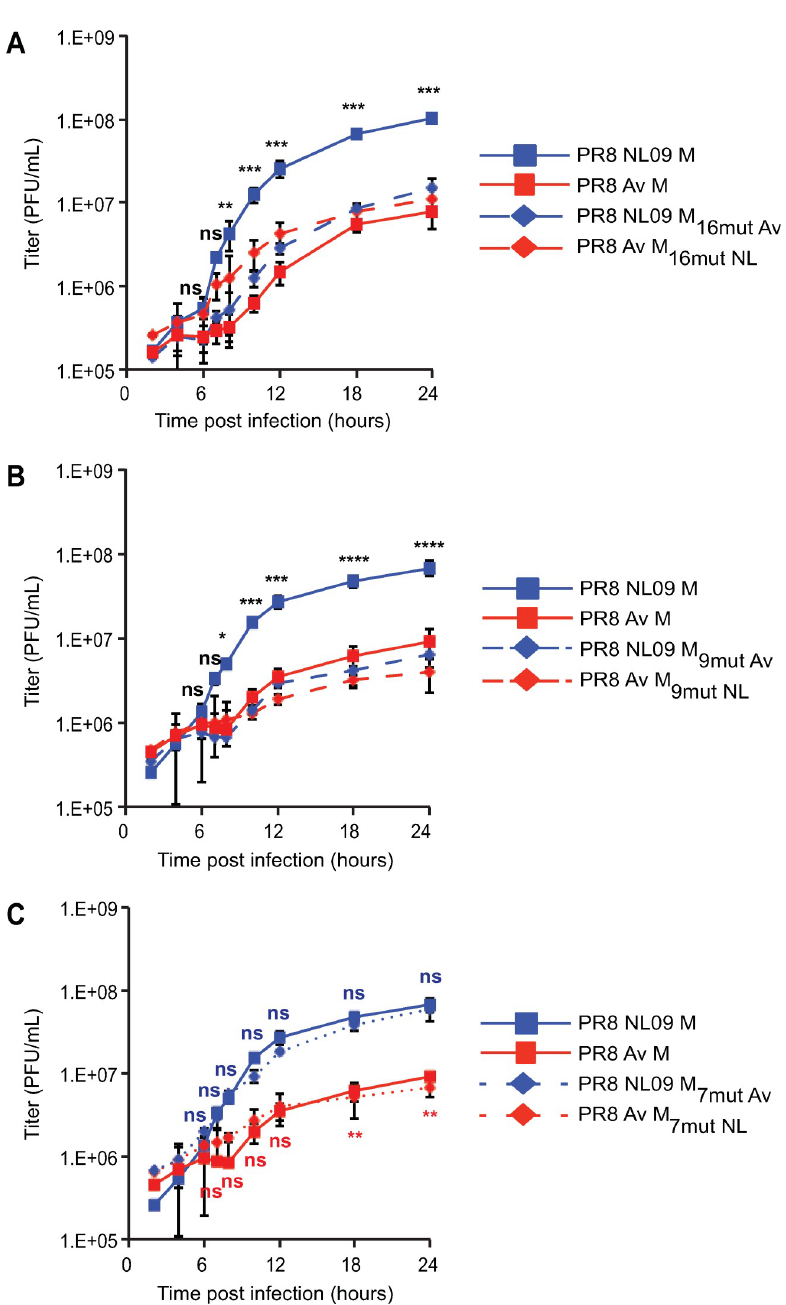
Fig 14. pH1N1 M amino acid sequences are not sufficient to confer high growth phenotype in A549 cells. PR8 NL09 M virus and PR8 avian M virus, along with six PR8-based viruses carrying avian-human chimeric M segments, were inoculated at a MOI of 5 PFU/cell onto A549 cells. Virus growth was measured by plaque titration. The effects on viral growth of amino acid changes in (A) both M1 and M2, (B) M1 only and (C) M2 only are shown. Single-cycle growth was assessed in at least three independent experiments, with three technical sample replicates per experiment. Graphed data show the means with SD for at least three experiments. Statistical significance was determined using repeated measures, two-way, multiple ANOVA on log-transformed values, with Bonferroni correction applied to account for comparison of a limited no of means. Experiments involving PR8 NL09 9mut or 7mut viruses as well as PR8 Av M 9mut or 7mut viruses were performed at the same time, but are displayed on two separate graphs with the same PR8 NL09 M and PR8 avian M control virus data, to improve clarity of presentation.